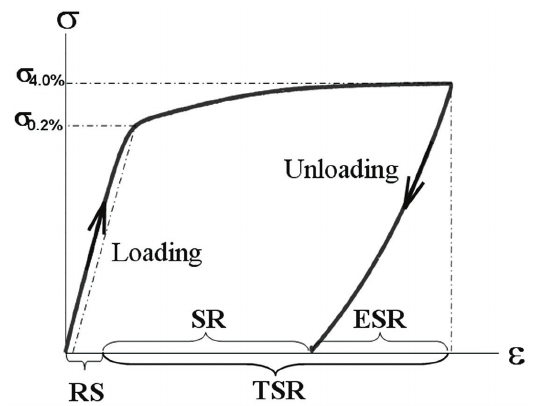
Figure 1. Schematic of the tensile test for measuring the shape recovery. The parameters are as follow: TSR (Total Shape